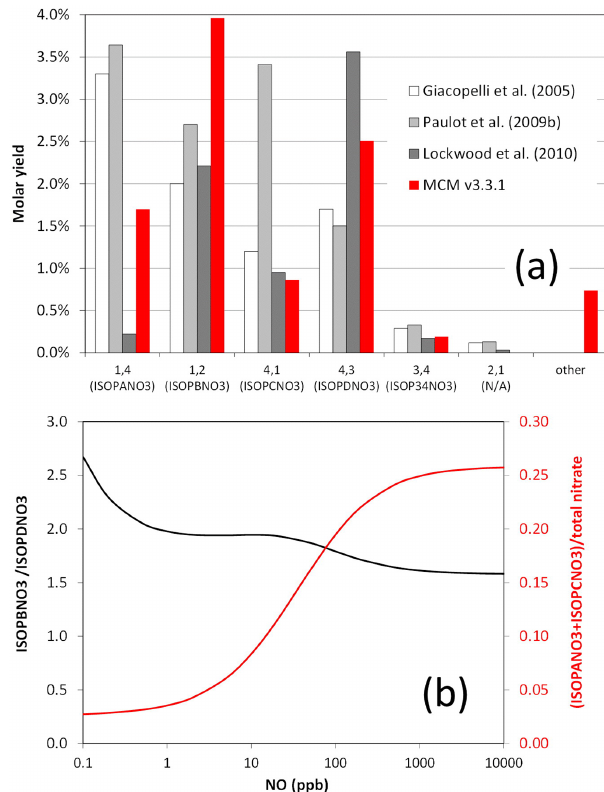
Figure 5. (a) Reported molar yields of speciated nitrate prod- ucts formed from the first-generation OH-initiated oxidation of isoprene (see Fig. 7 for structures). The “1,4” and “4,1” cate- gories include contributions from both E and Z isomers, where reported. The MCM v3.3.1 values correspond to 298K at the high [NO] limit (see Fig. 3), with the total yield being 10%. The “other” category includes C524NO3 (formed in the mechanism to HMACR formation), C526NO3 (formed in the mechanism to methyl glyoxal/glycolaldehyde formation) and C527NO3 (formed in the mechanism to glyoxal/hydroxyacetone formation). The “2,1” isomer is not formed in MCM v3.3.1. (b) [NO] dependences of the ratio of the β -hydroxy isomers (ISOPBNO3 / ISOPDNO3) and the fractional contribution of the δ -hydroxy isomers (ISOPANO3 and ISOPCNO3). The displayed [NO] range corresponds to values of k tr in the approximate range 0.022–2200s − 1